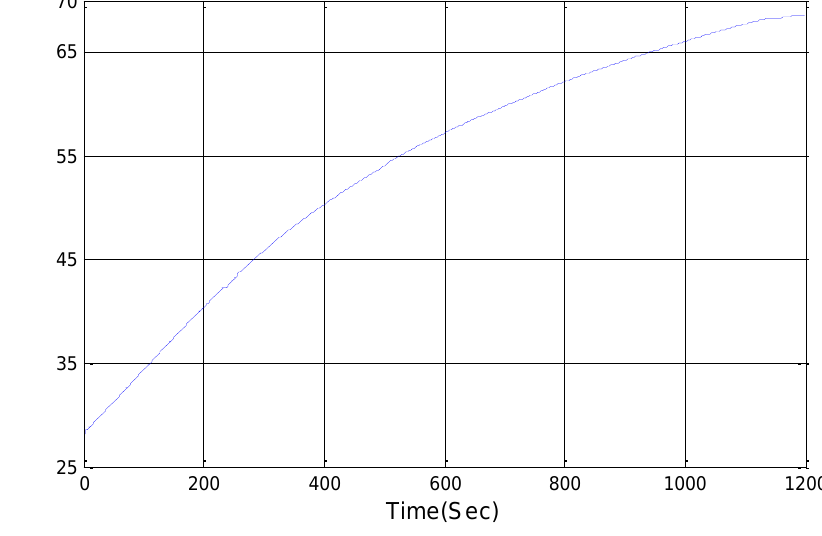
Figure 11. The measured RSSI according to the temperature